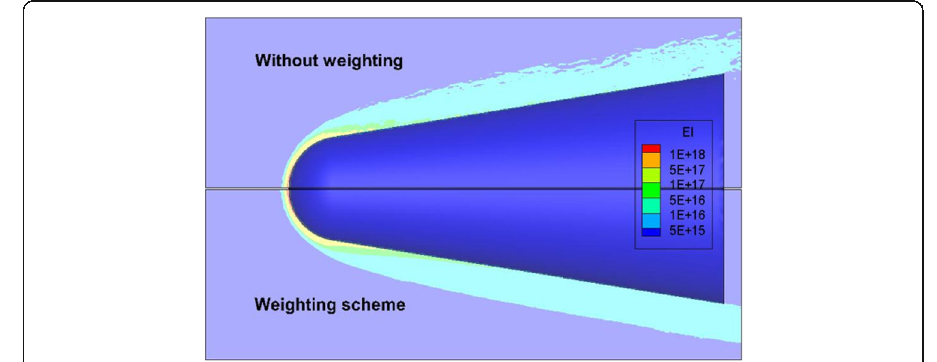
Fig. 7 The electron number density per m 3 for RAM-C II at 81